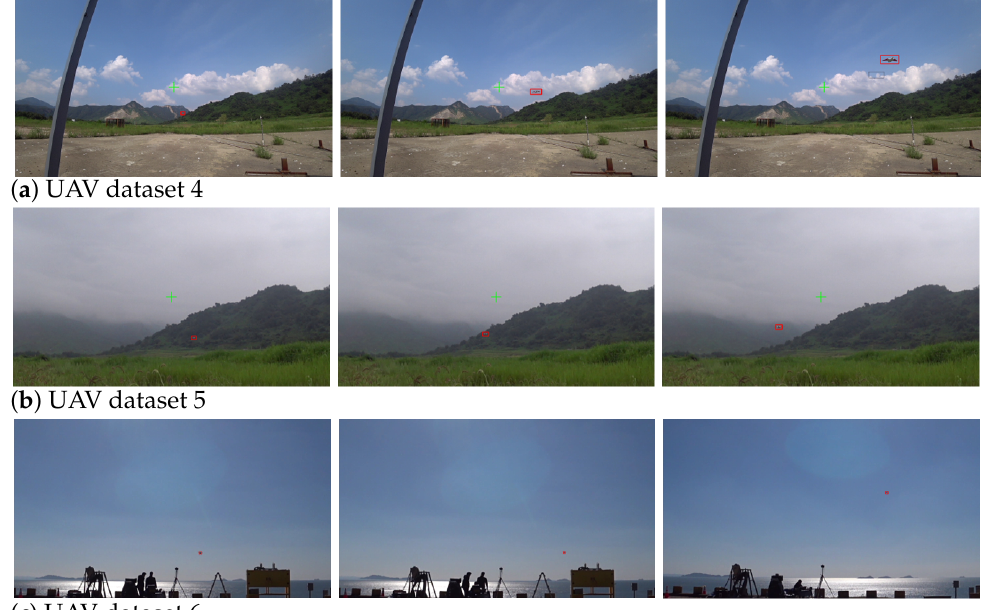
Figure 6. Qualitative results 3 using our UAV datasets. Red boxes denote visual tracking results of the proposed method.